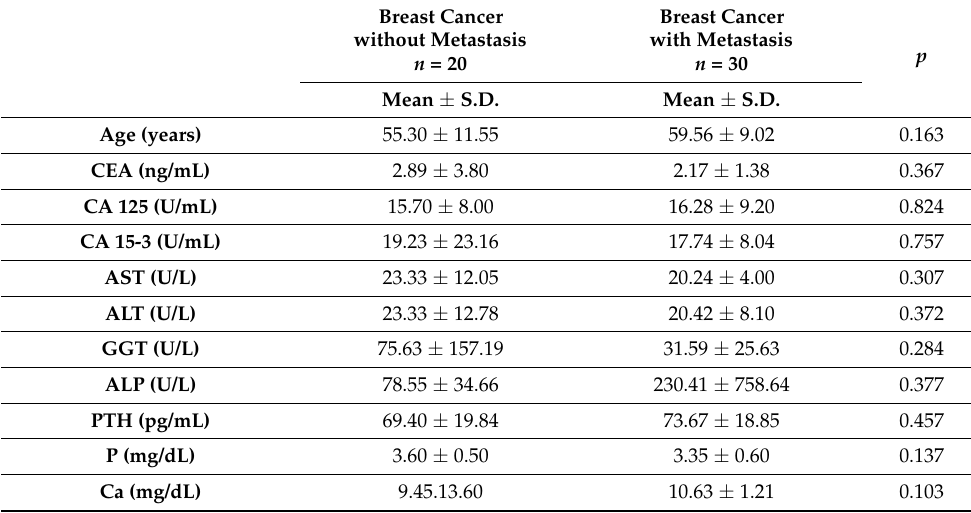
Table 2. Biochemical parameters in subgroups divided according to the presence of metastasis in breast cancer